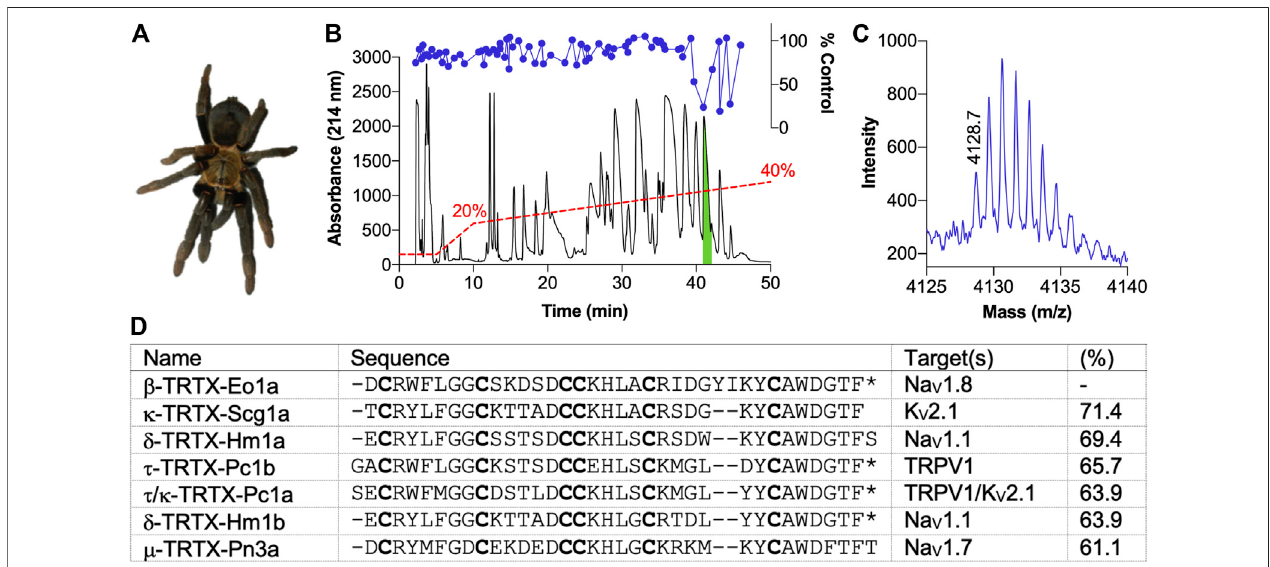
FIGURE1 | Isolation of the novel peptide β -TRTX-Eo1a from thevenom of Encyocratellaolivacea. (A) Photo ofafemale E.olivacea specimen from which crude venomwasobtained. (B) ChromatogramresultingfromfractionationofthecrudevenomusingRP-HPLC(reddashedlineindicatesacetonitrilegradient).Corresponding activity ofeachfraction tomodulatedeltamethrin-inducedNa V 1.8responsesisshownabove (bluecircles).Thegreenindicates theactive peakthatwasfollowedup. (C) MALDI-TOFMSspectrumshowingtheM+H + ionsforthedominantmasspresentintheactivepeak. (D) SequenceofEo1aidenti fi edbyN-terminalsequencingand alignment to selected spider-venom peptides with a known target from UniProt (www.uniprot.org). Cysteine residues are shown in bold; *, amidated C-terminus. Percentage indicates sequence